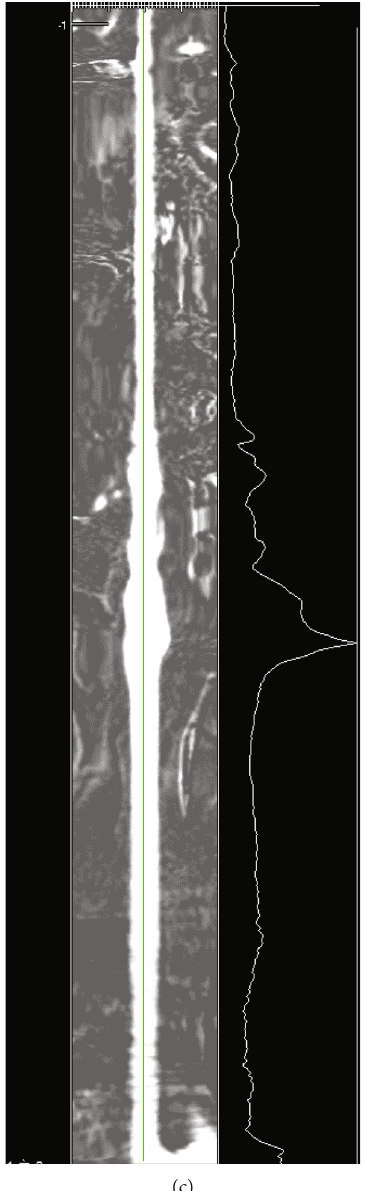
Figure 1: Measurement of arterial tortuosity computed tomography angiography (CTA), illustrated by the example of carotid artery (CA). (a) Left CA in multiplanar reformation. (b) The straight length (red line) and actual length (green line) are measured in three-dimensional reconstructed CTA. (c) The green line represents the actual length of left CA by using curved planar